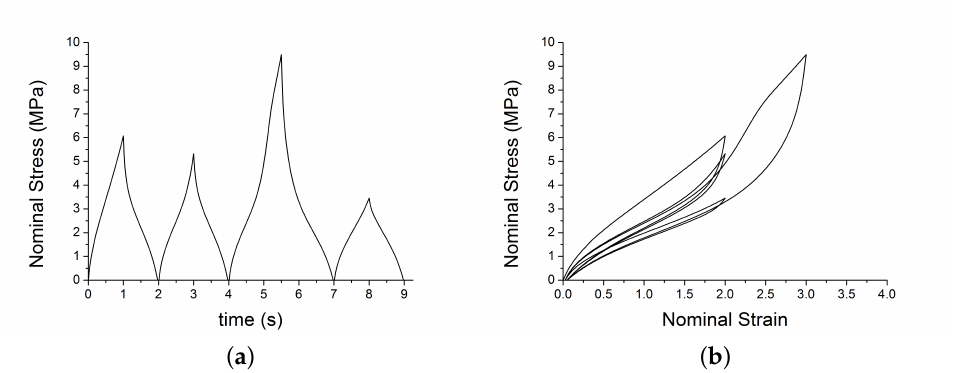
Figure 12. Test 2: VUMAT output: ( a ) shows the nominal stress; ( b ) shows the nominal strain–stress path with the set of parameters in Table 2.